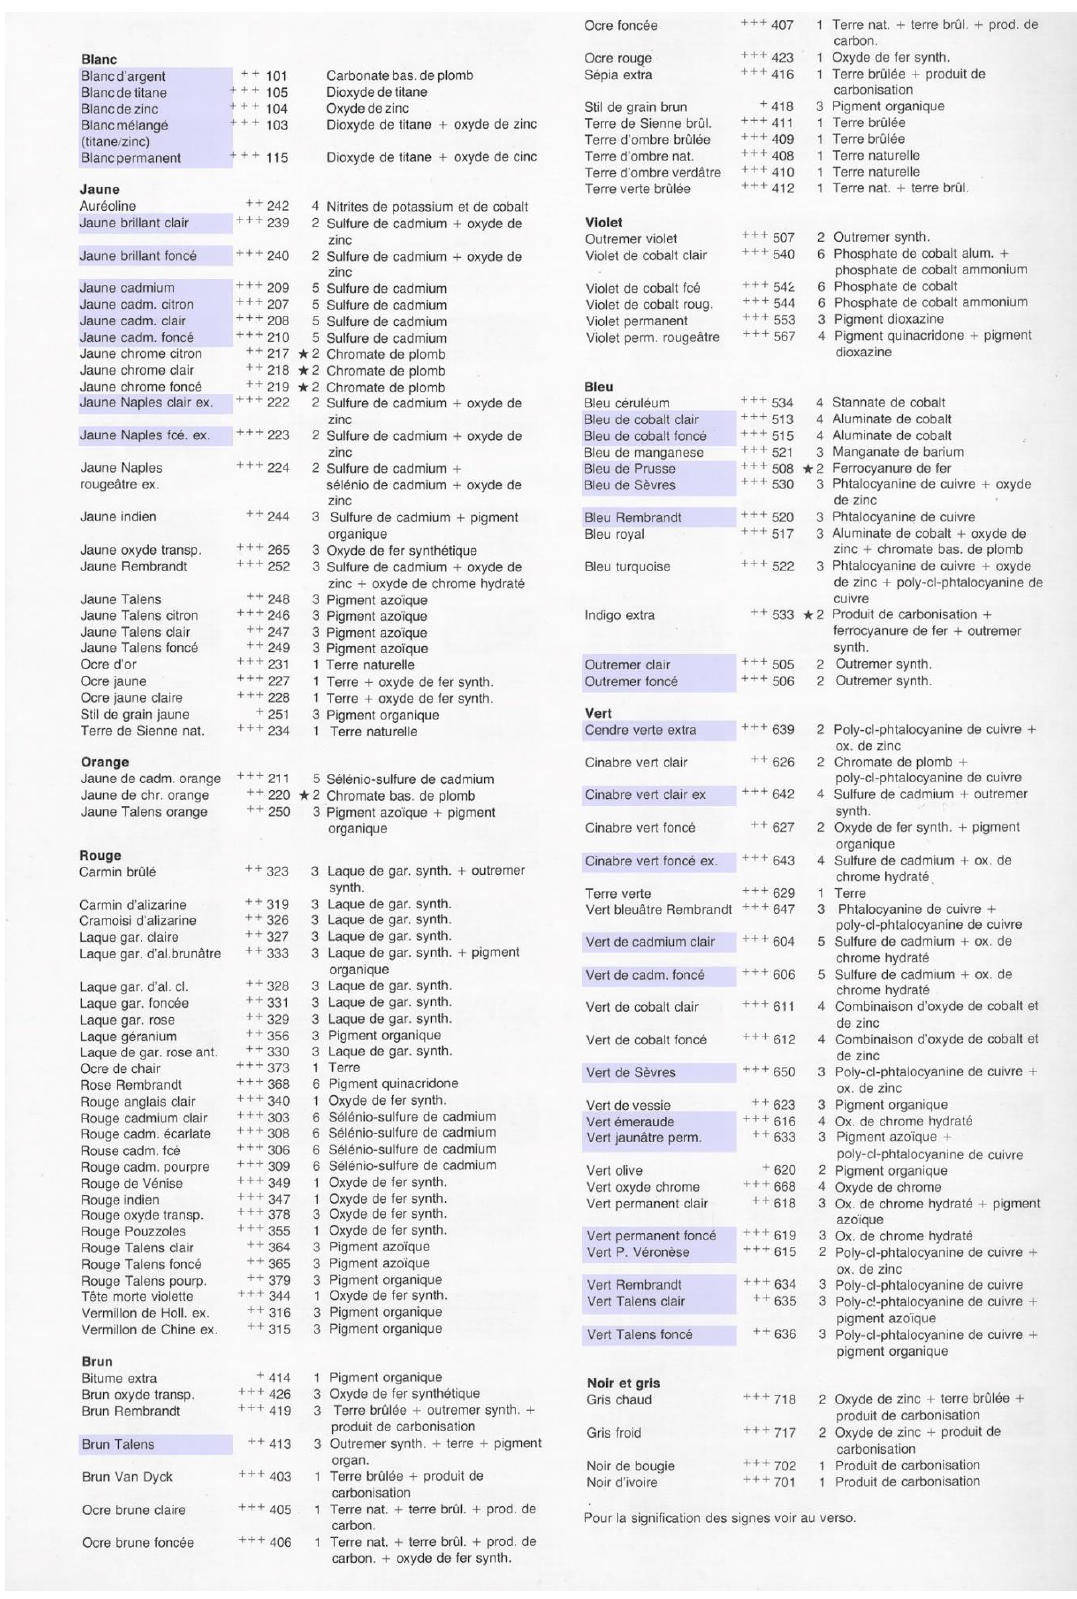
Figure A1. Oil colours and their pigment compositions, listed in the catalogue of Royal Talens (French edition) from 1982. The highlighted details indicate colours that could be tentatively linked to the identified pigment mixtures.